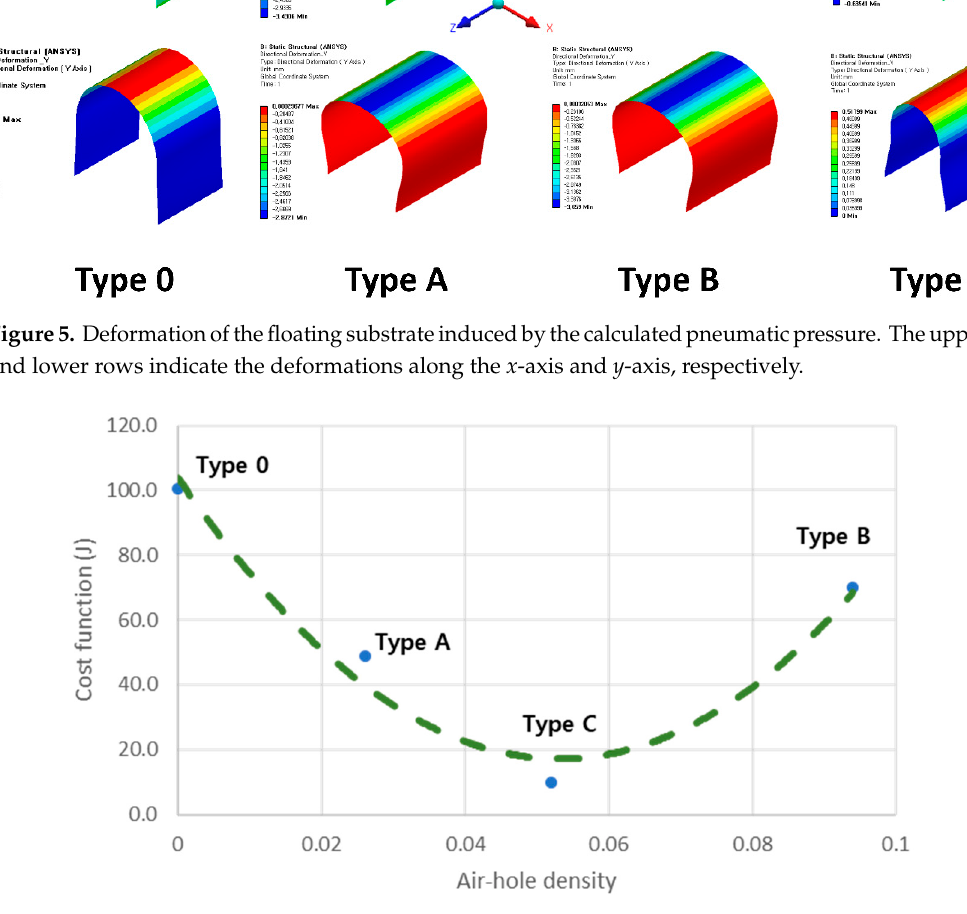
Figure 6. Cost function ( J ) as a function of air-hole density.